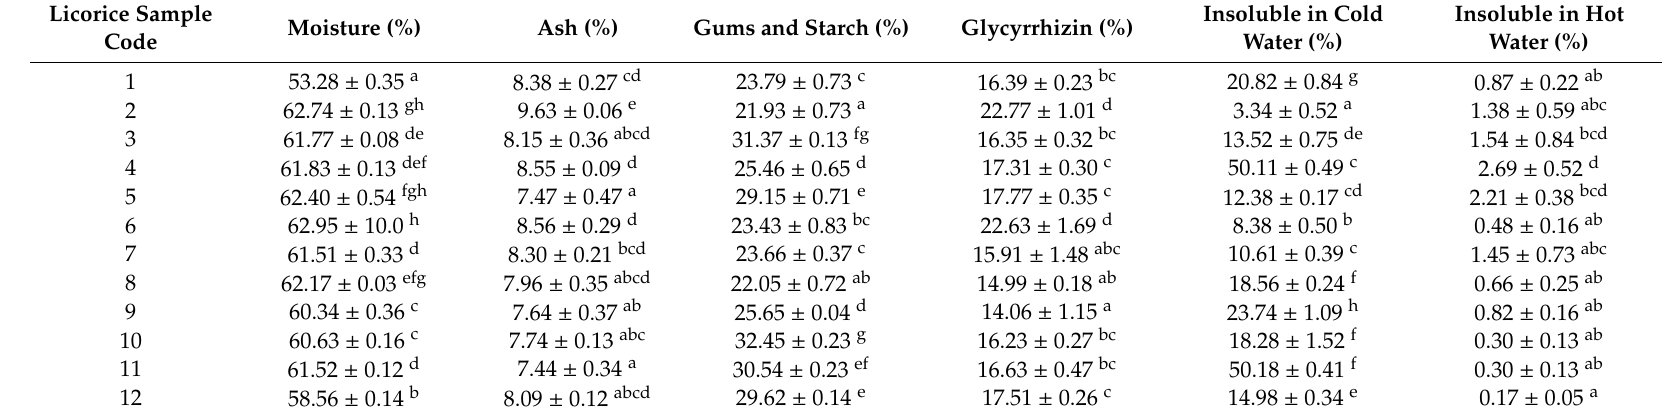
Table 1. The chemical composition (dry weight basis) of twelve licorice extract samples (sample codes of 1–12) that were harvested at various seasons and produced at commercial licorice processing